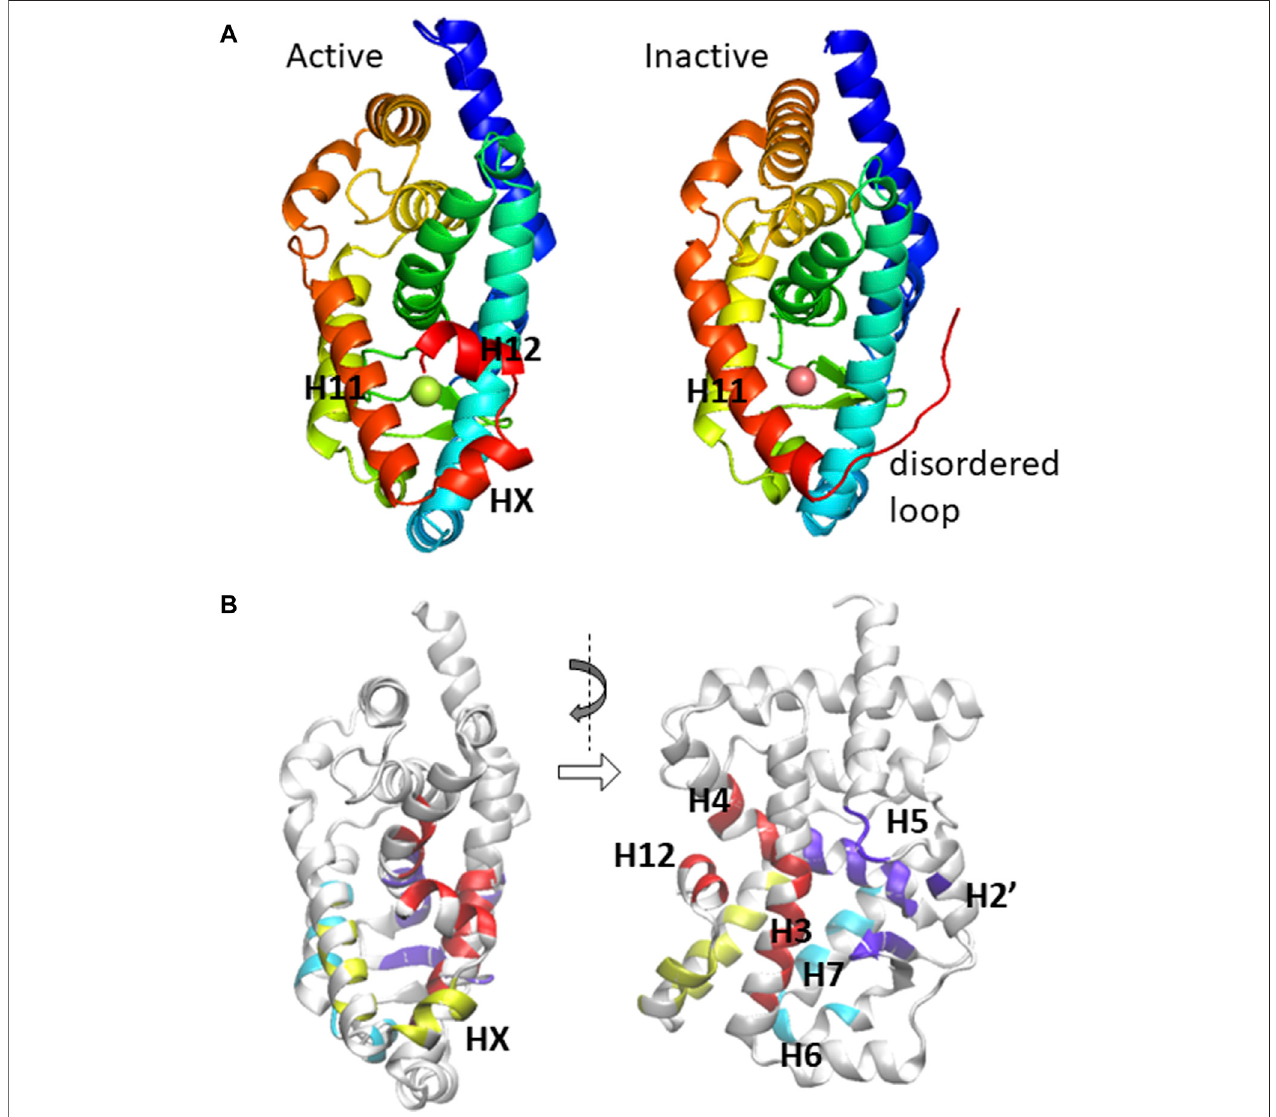
FIGURE1|(A) Theligand-bindingdomainofROR γ isdisplayedinactive(PDB:3L0L)andinactive(PDB:4QM0)conformations.Theimportantsecondarystructural elements that undergo conformational change are located at the C-terminal region and are explicitly labeled. (B) The residues that potentially form direct contact with ligands are shown in a canonical front view and a side